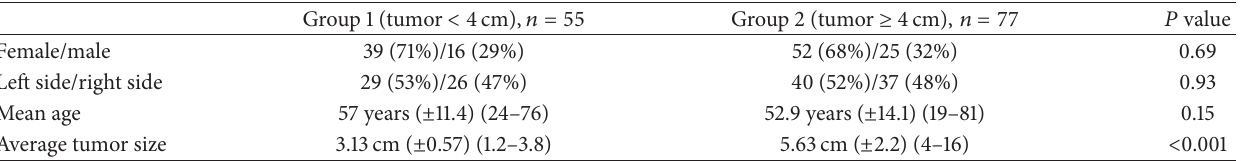
Table 1: Characteristics of the study groups of